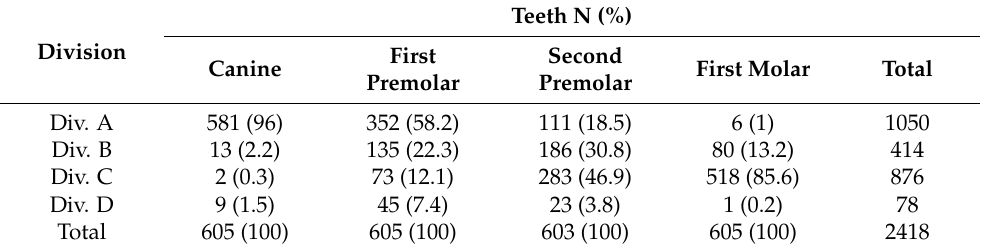
Table 2. Division